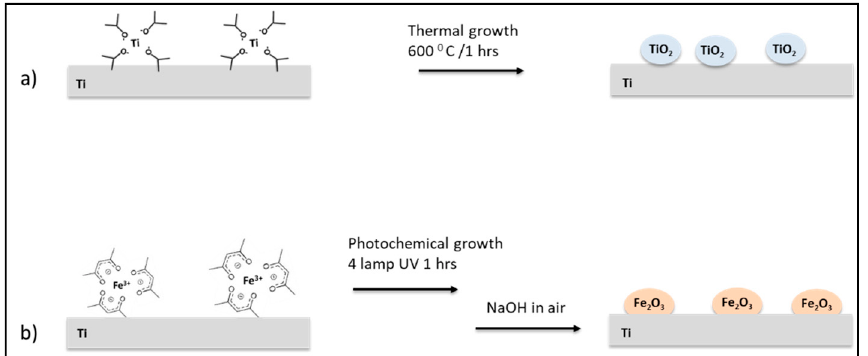
Figure 1. Schematic representation of titanium scaffold surface nano-functionalization processes with ( a ) TiO 2 and ( b ) γ Fe 2 O 3 .